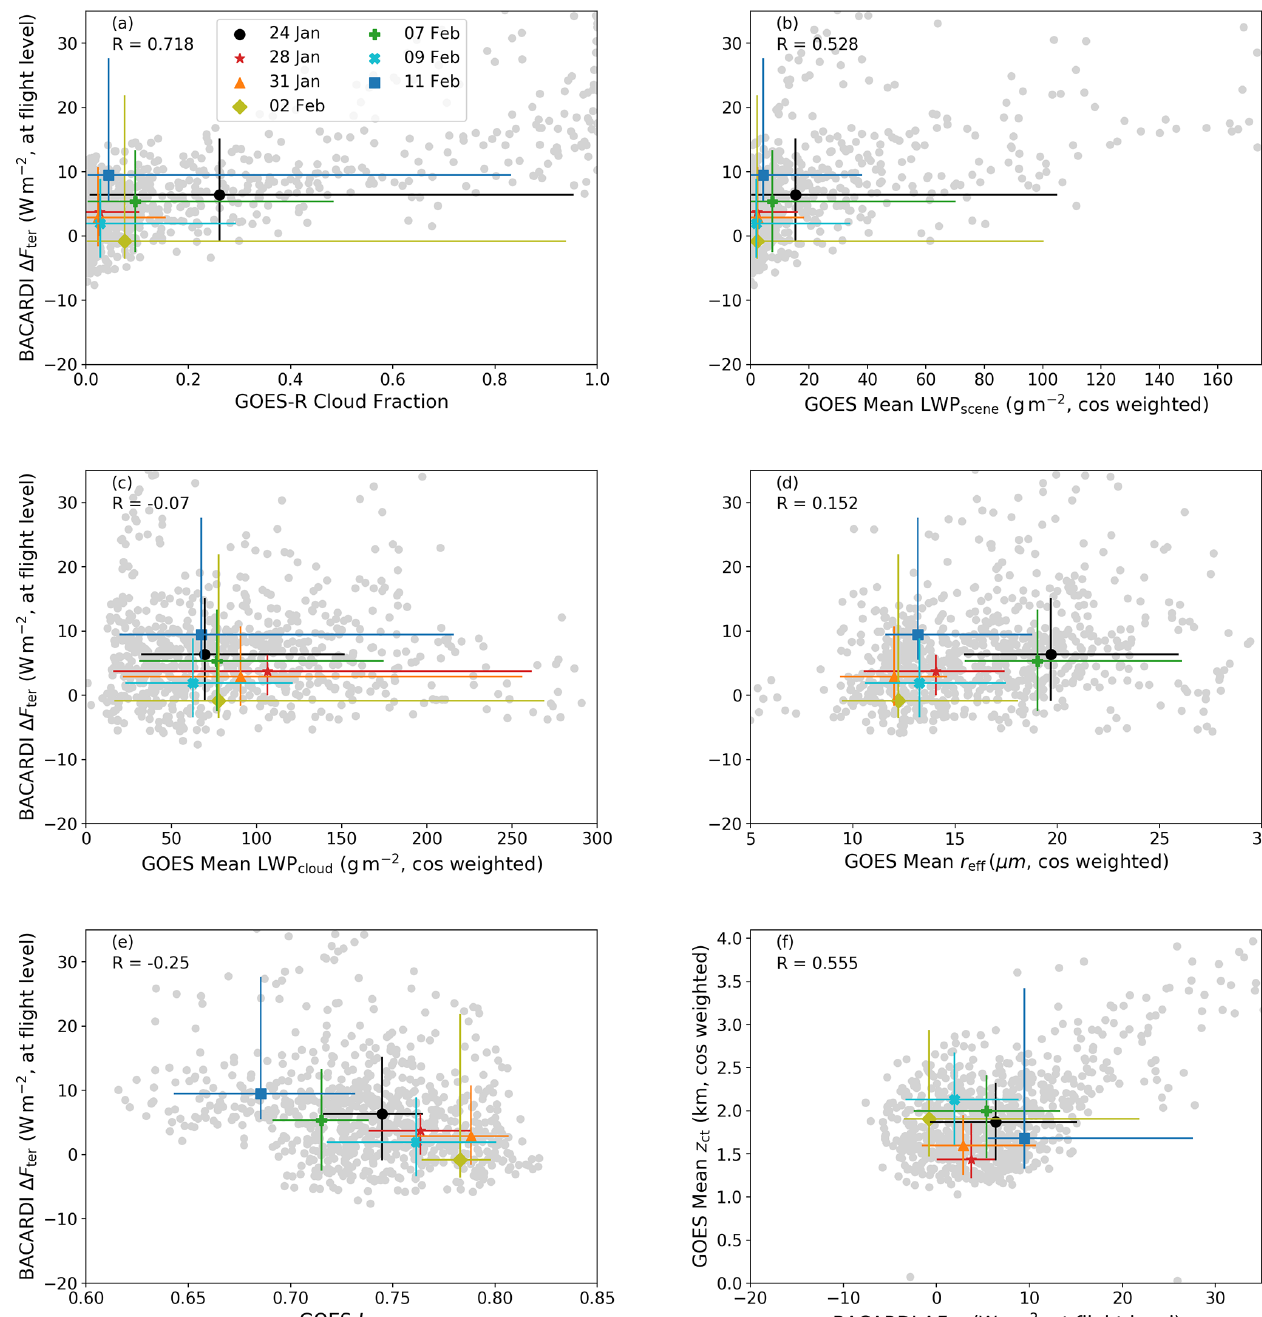
Figure 4. Same as Fig. 3 but for (cid:49)F ter .